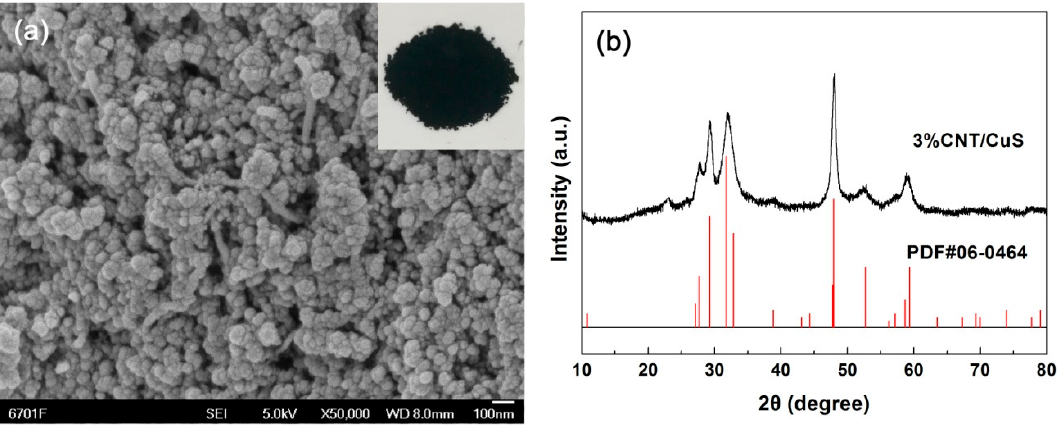
Figure 5. SEM image ( a ) and XRD pattern ( b ) of the 3% CNT/CuS composite.